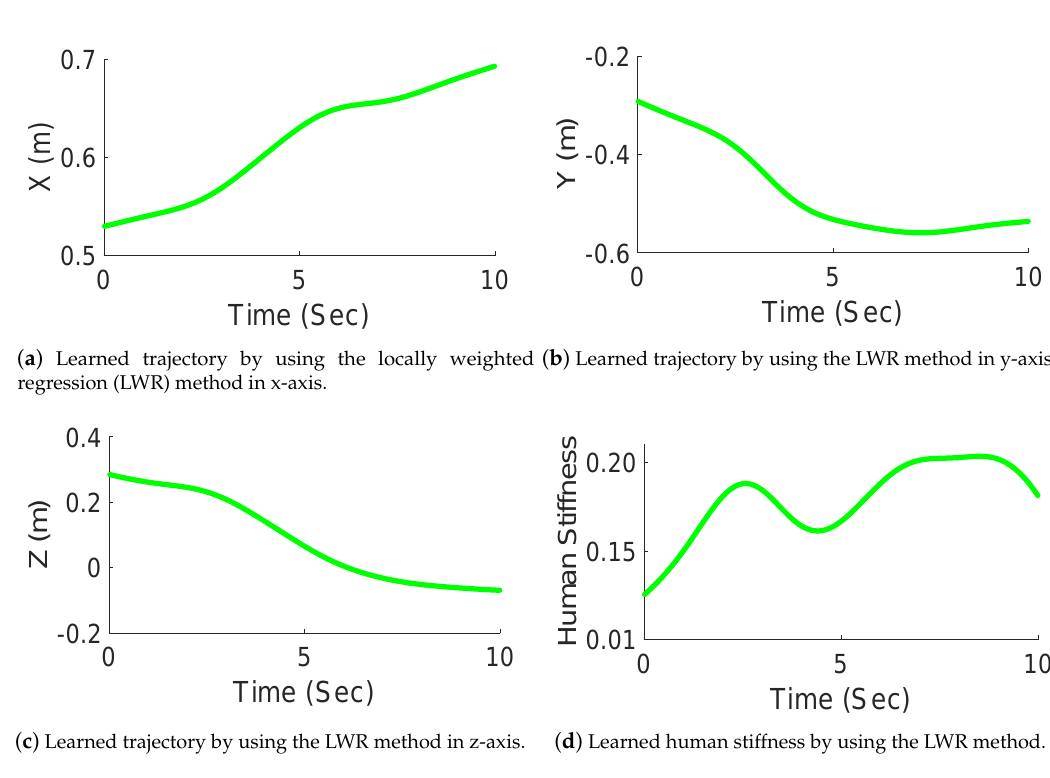
Figure 9. Learning by using the LWR method.